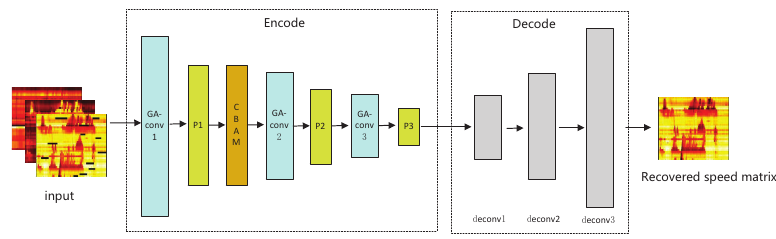
Figure 3. The generator of